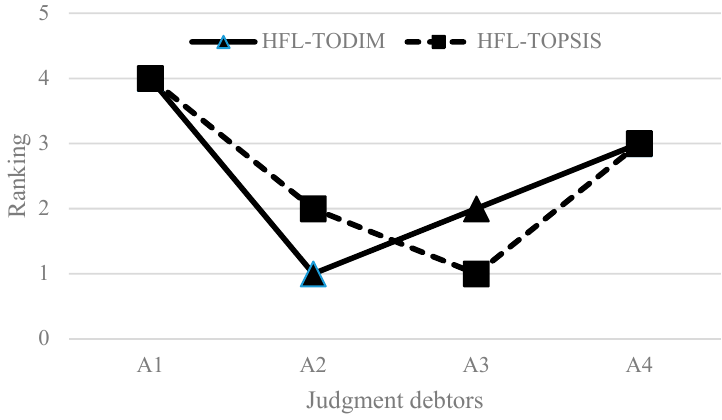
Figure 2. Evaluation results by two different methods.